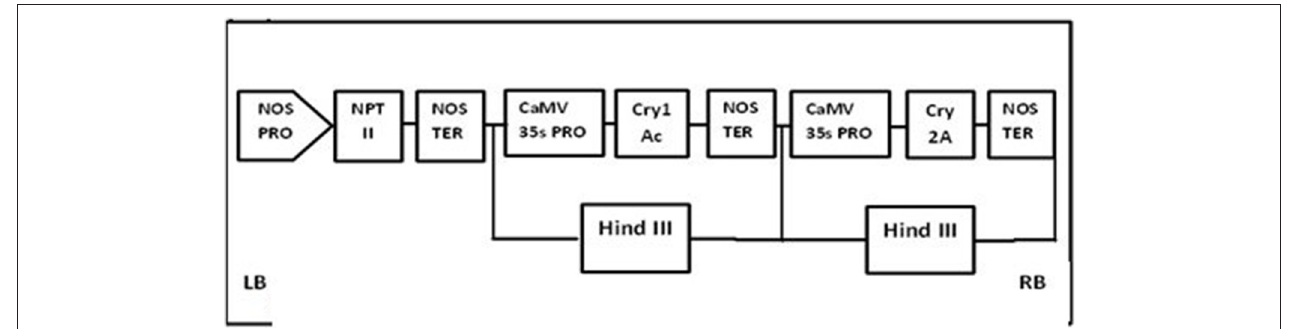
FIGURE 1 | Physical maps of CrylAc + Cry2A